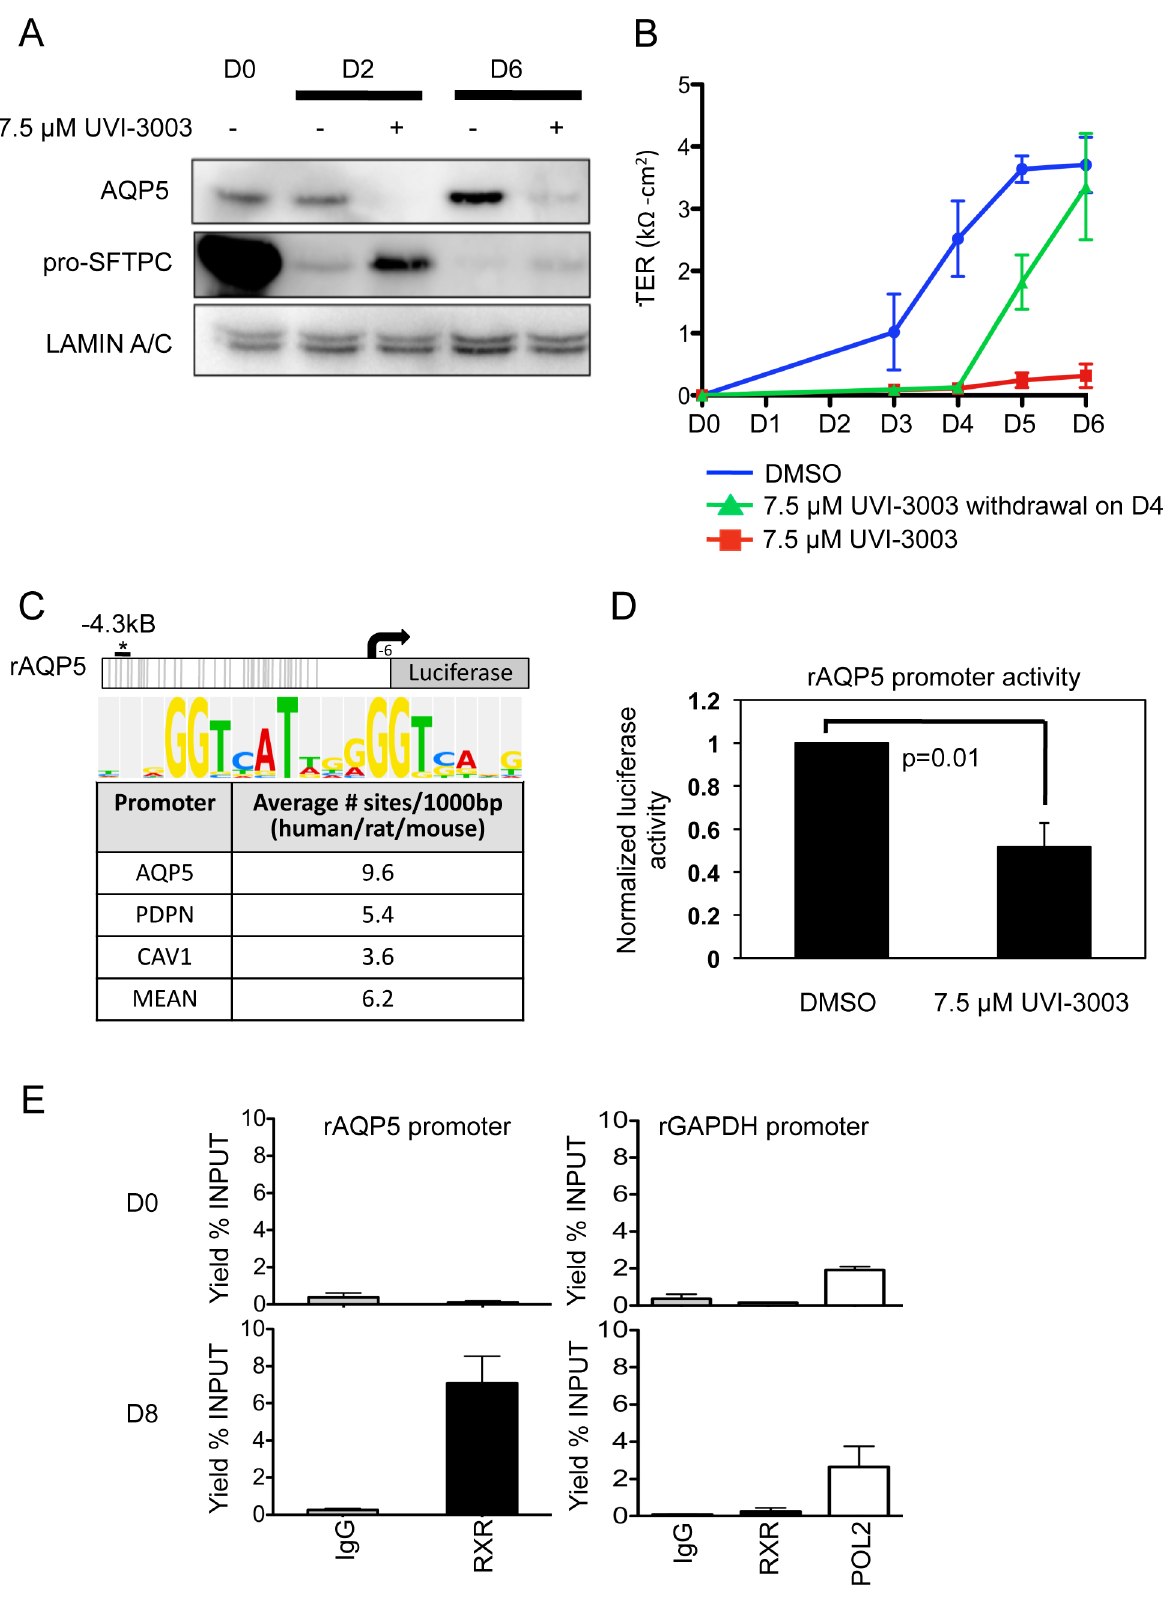
Figure 5. Functional validation of a transcription factor signaling pathway predicted from bioinformatics analysis. A) Western blots examining AT2 and AT1 cell markers during differentiation in the presence or absence of RXR antagonist UVI-3003. LAMIN A/C is the loading control. B) Transepithelial resistance as measured in k V -cm 2 over the course of differentiation. Error bars represent technical duplicates for each plating. C) Rat